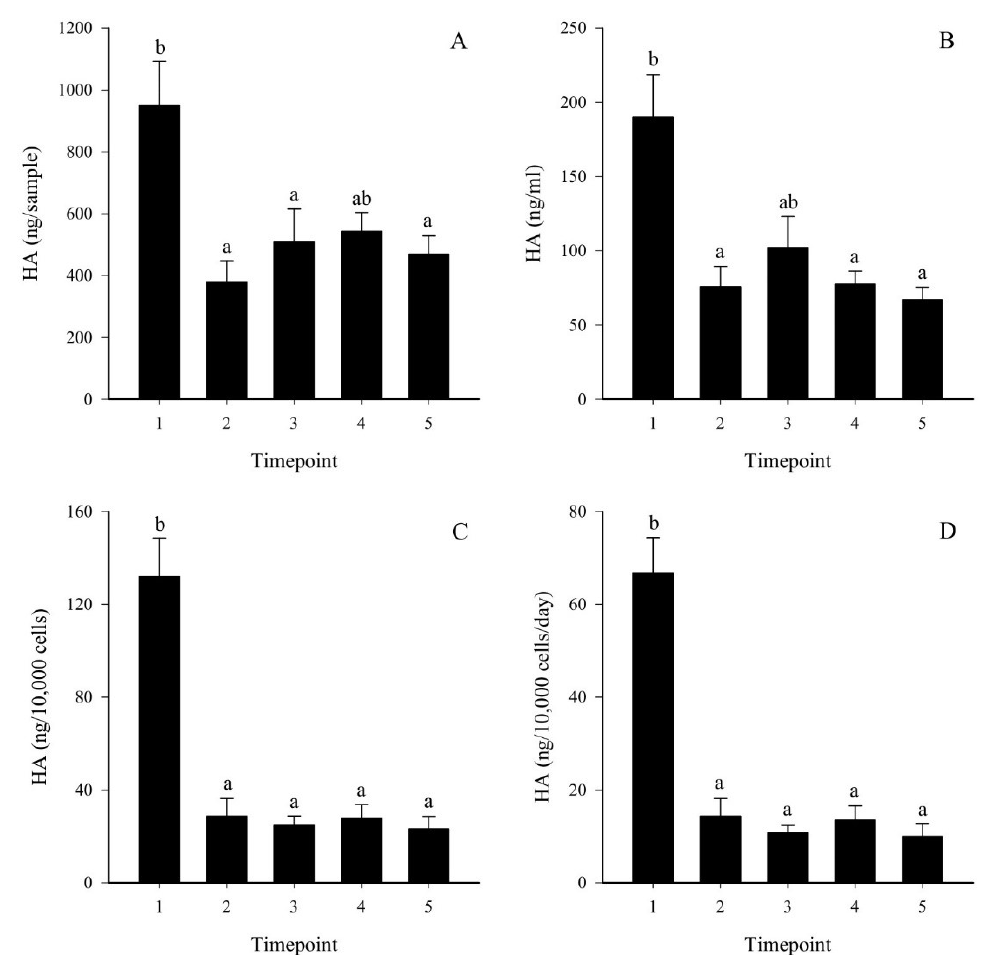
Figure 4. Temporal changes in hyaluronan (HA) concentrations in conditioned medium of fibroblast-like synoviocytes (mean + SE), represented as ng/sample (panel ( A )), ng/mL (panel ( B )), ng/10,000 cells (panel ( C )), and ng/10,000 cells/day (panel ( D )). Timepoint 1 = lag phase, timepoints 2–3 = proliferating cells, timepoints 4–5 = high-density cells. Means with dissimilar letters indicate significant differences between timepoints (Kruskal–Wallis ANOVA, p < 0.05).